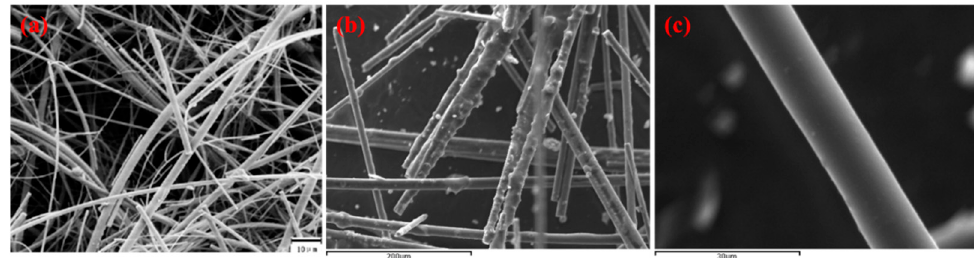
Figure 3. Scanning Electron Microscopy images of ( a ) uncoated glass fiber; ( b ) sol–gel PDPS coated glass fibers; ( c ) magnified image of sol–gel PDPS coated individual glass fiber.